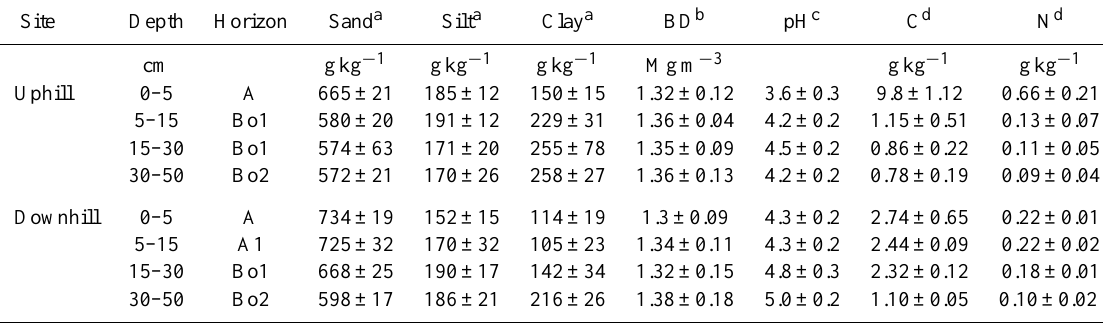
Table 1. Main chemico-physical characteristics (±1 stdev, n = 6) of the soil sampled in the study areas. Site Depth Horizon Sand a Silt a Clay a BD b pH c C d N d cm gkg − 1 gkg − 1 gkg − 1 Mgm − 3 gkg − 1 gkg − 1 Uphill 0–5